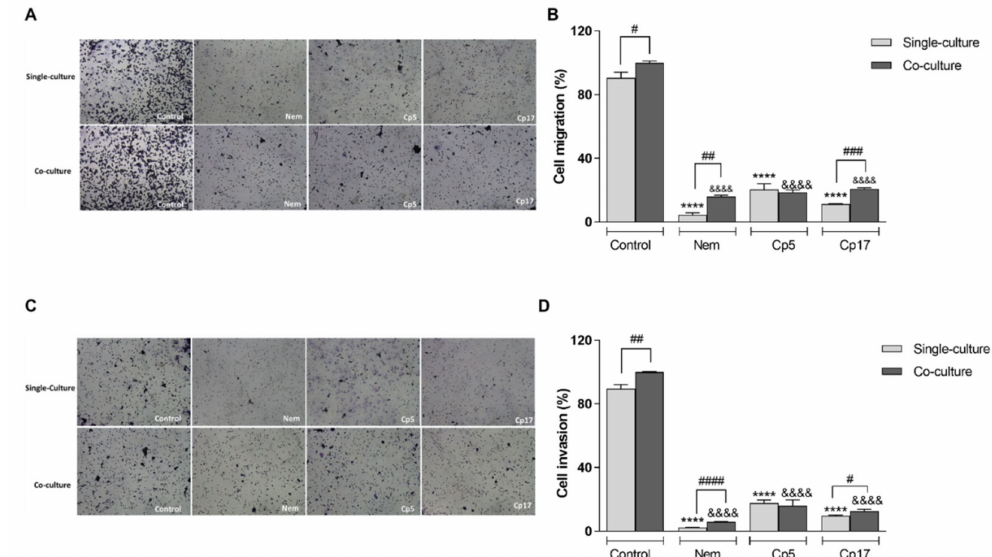
Figure 6. E ff ect of Nem, Cp5 or Cp17 (concentrations used, 12 µ M, 25 µ g / mL, 13 µ g / mL, respectively) on ( A , B ) migration and ( C , D ) invasiveness of HT-29 cells in single culture or co-cultured with M2-like macrophages. Data are expressed as mean ± SD of three di ff erent experiments. HT-29 cells: **** p < 0.0001 vs. control (single culture); &&&& p < 0.0001 vs. control (co-culture), # p < 0.05, ## p < 0.01, ### p < 0.001, #### p < 0.0001, di ff erences between single and